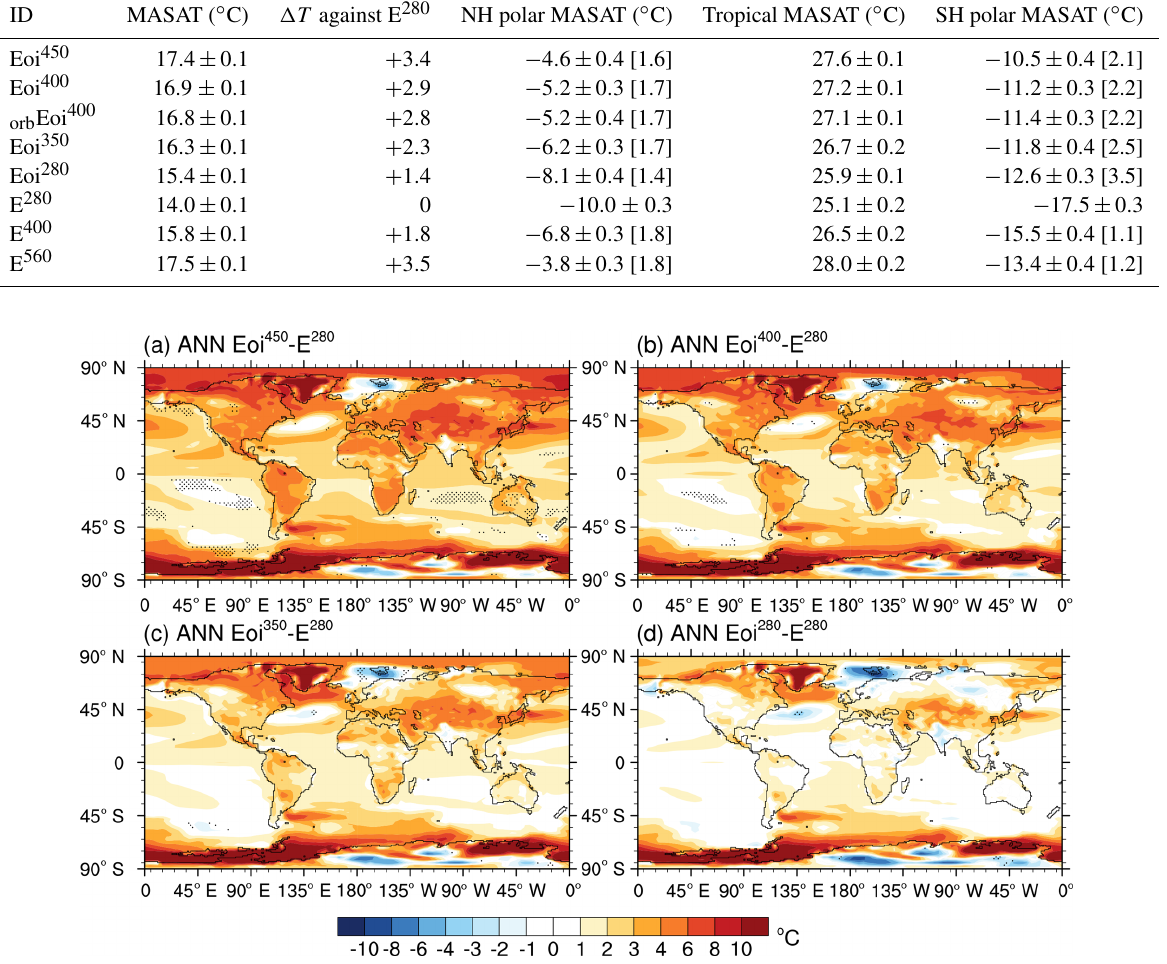
Figure 3. Pliocene annual mean surface air temperature anomalies against E 280 . (a) Eoi 450 –E 280 , (b) Eoi 400 –E 280 , (c) Eoi 350 –E 280 and (d) Eoi 280 –E 280 . Stippling indicates regions in which results are not statistically significant at a 95% confidence criterion (independent two-sample Student’s t